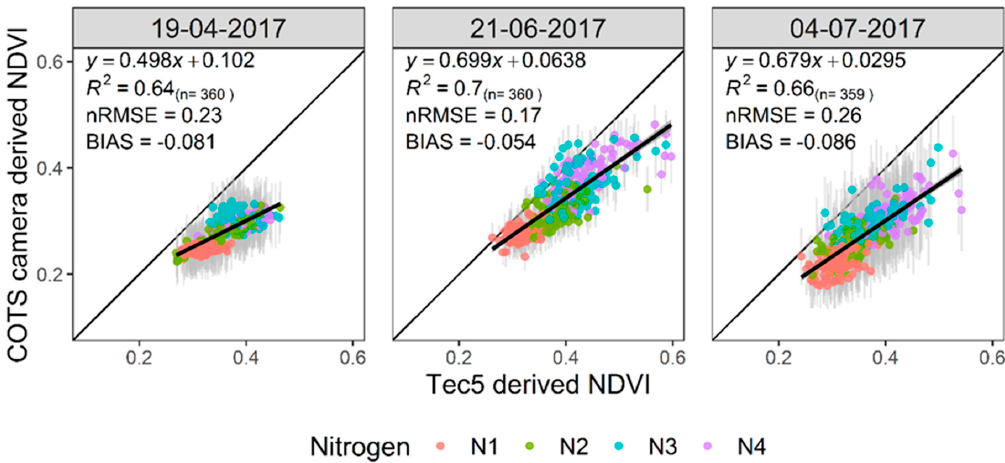
Figure 14. Accuracy assessments of NIR band reflectance for three dates. Tec5 reflectance is convolved to the spectral response of the COTS cameras for comparison. The points are coloured based on nitrogen treatment applied to the plot. Standard deviation of reflectance measured by the COTS cameras is presented by vertical error bars. The dashed line represents the 1:1 line.